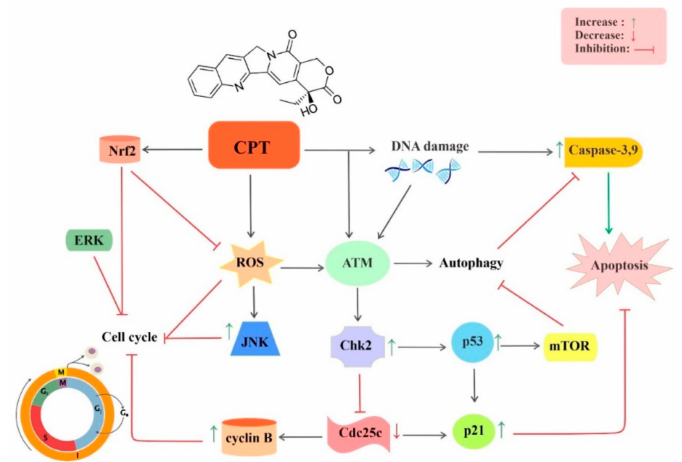
Figure 2. Molecular mechanisms underlying the anticancer effect of CPT. Abbreviations: ATM, ataxia telangiectasia mutated gene; Cdc25c, cell division cycle 25C; Chk2, checkpoint kinase 2; CPT, camptothecin; ERK, extracellular signal-regulated kinase; JNK, c-Jun N-terminal kinase; mTOR, mammalian target of rapamycin; Nfr2, nuclear factor erythroid 2–related factor 2; p21, tumor protein p53; p53, tumor protein p53; ROS, reactive oxygen